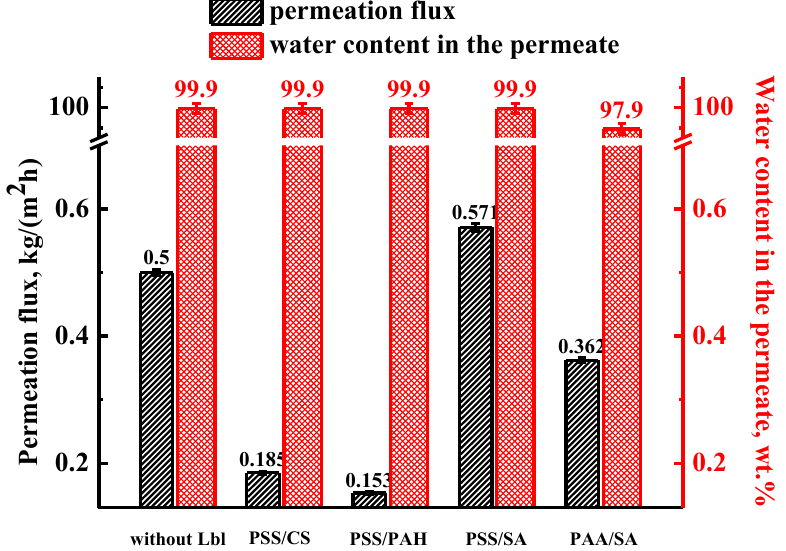
Figure 5. The transport parameters (permeation flux and water content in the permeate) of the cross-linked PAN-supported membranes based on SA without and with surface modification with five bilayers of different polyelectrolyte combinations (PSS/CS, PSS/PAH, PSS/SA, and PAA/SA) by Lbl assembly in the pervaporation separation of an azeotropic water/isopropanol (12/88 wt.%) mixture at 22 ◦